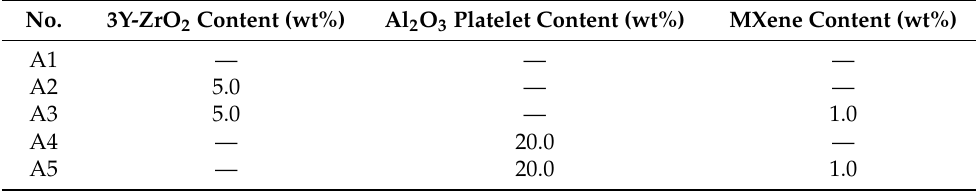
Table 1. Composition of the